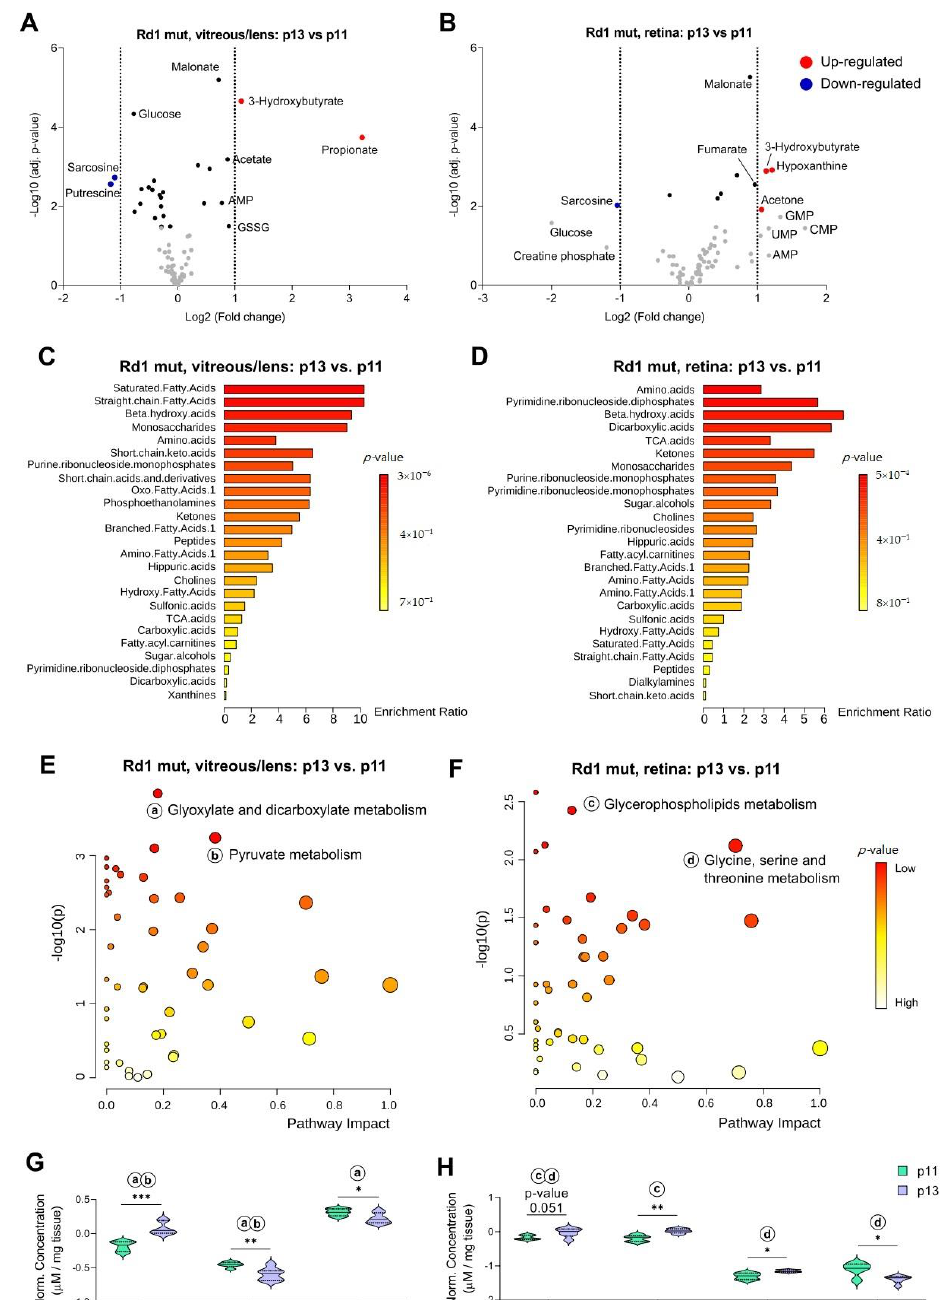
Figure 4. Photoreceptor degeneration affects the metabolite composition of vitreous/lens and retina across time. ( A , B ) Vol- cano plots with the differences between time-point p13 and p11 of metabolites concentration in the vitreous/lens ( A ) and the retina ( B ) of Rd1 mutant mice. ( C , D ) Quantitative metabolite set enrichment analysis showing the metabolite classes enriched in vitreous/lens ( C ) and retina ( D ) between the two time-points. ( E , F ) Pathway analysis with the significance of the time-point comparison in the vitreous/lens ( E ) and retina ( F ) in relation to the topology (impact). Selected pathways with a high significance are indicated (small letters). ( G , H ) Violin plots with summary quantification data of metabolites with a high significance within the indicated pathways in subfigures ( E , F ) in the vitreous/lens ( G ) and retina ( H ). The concentrations are showed at both time-points. The letters indicate the pathway in subfigures ( E , F ) in which the metabolites are found. Vitreous/lens: n = 6 (p11), n = 7 (p13). Retina: n = 5 (p11), n = 6 (p13). Multiple unpaired t test with Holm–Š í d á k correction for multiple comparisons. * p < 0.05, ** p < 0.01, *** p <